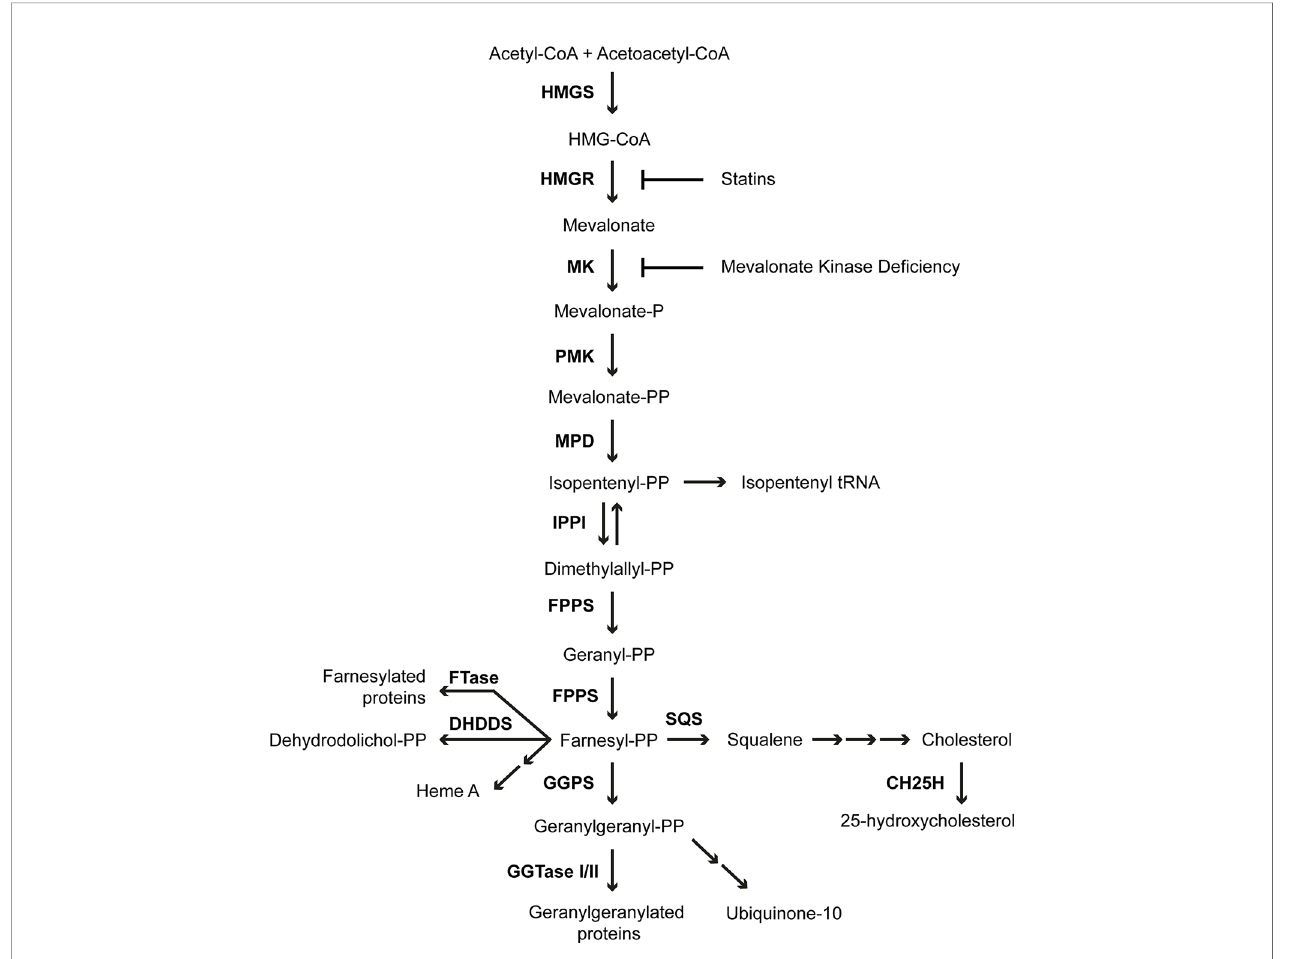
FIGURE 1 | Isoprenoid biosynthesis pathway. The enzymes of the pathway are 3-hydroxy-3-methylglutaryl-CoA synthase (HMGS), 3-hydroxy-3-methylglutaryl-CoA reductase (HMGR), mevalonate kinase (MK), phosphomevalonate kinase (PMK), mevalonate pyrophosphate decarboxylase (MPD), isopentenyl pyrophosphate isomerase (IPPI), farnesyl pyrophosphate synthase (FPPS), farnesyltransferase (FTase), dehydrodolichyl diphosphate synthase (DHDDS), geranylgeranyl pyrophosphate synthase (GGPS), geranylgeranyltransferase (GGTase), squalene synthase (SQS) and cholesterol 25-hydroxylase